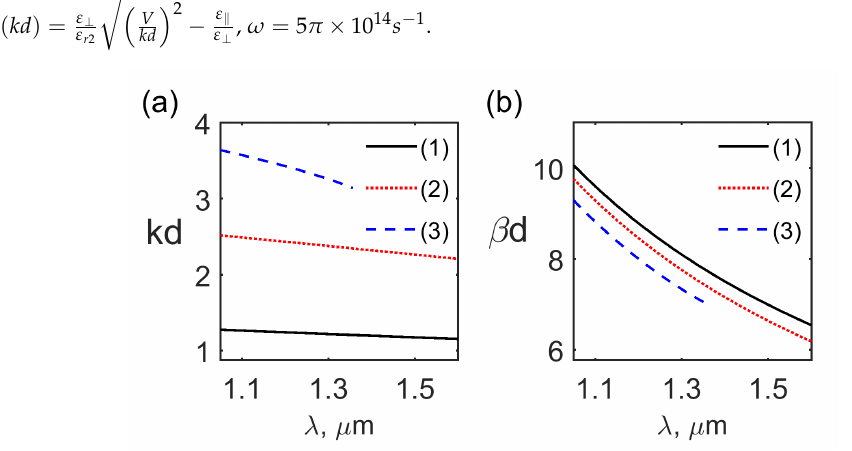
Figure 3. The normalized wavenumber kd ( a ) and propagation constant β d ( b ) dependence on the optical wavelength λ for the even modes TM even